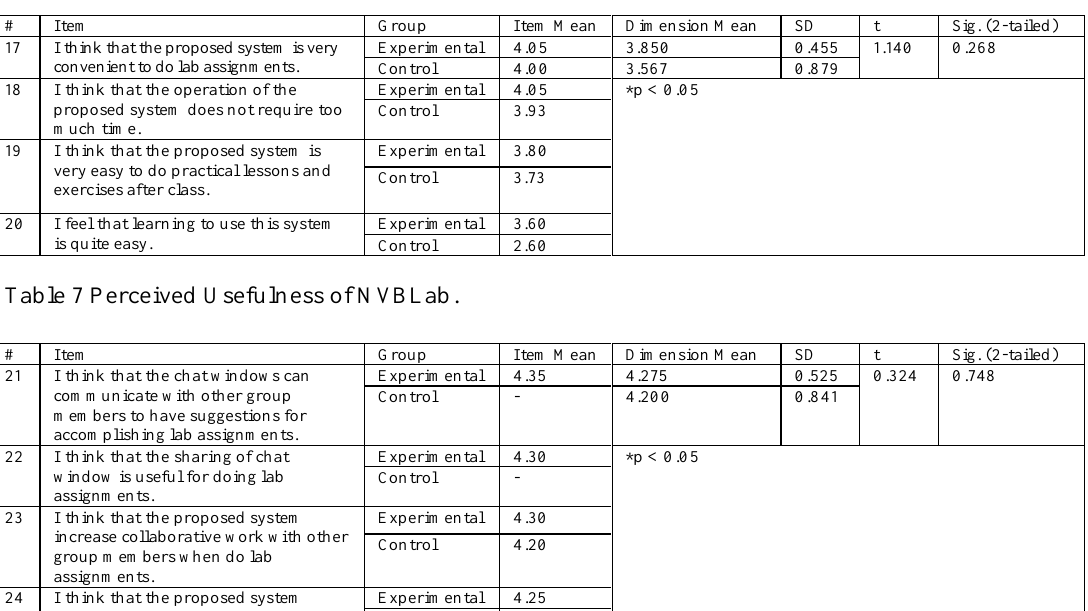
Table 6 Perceived Ease of NVBLab use.